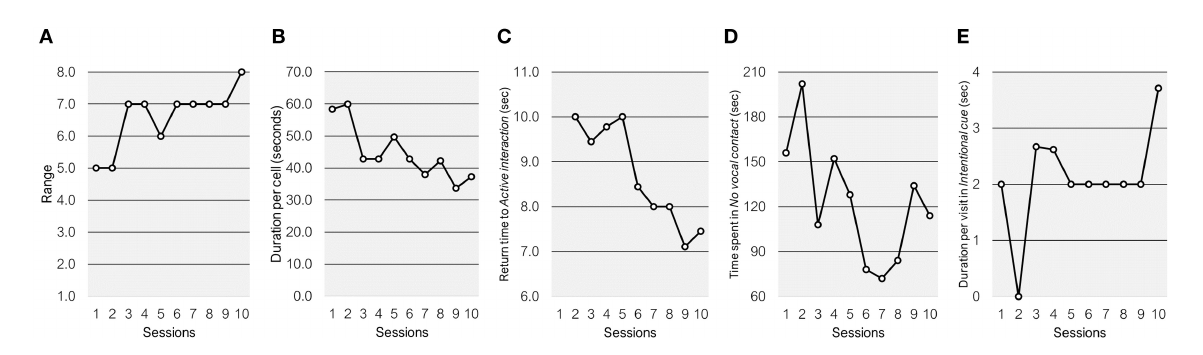
FIGURE4 Whole grid and region of interest measures across the ten sessions. (A) Range; (B) duration per cell; (C) return time to the active interaction region; (D) time spent in the no vocal contact cell; (E) duration per visit in the intentional cue